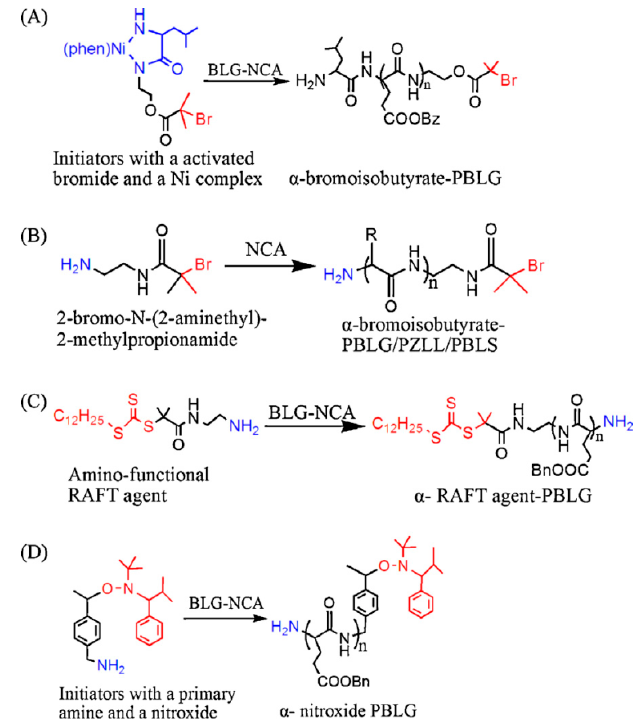
Figure 30. Dual initiators capable of promoting NCA polymerization and controlled radical polymerization. ( A , B ) Dual initiators for NCA polymerization and atom transfer radical polymerization (ATRP); ( C ) dual initiators for NCA polymerization and reversible addition-fragmentation chain-transfer (RAFT) polymerization; and ( D ) dual initiators for NCA polymerization and nitroxide-mediated radical polymerization (NMP). Reproduced with permission from reference [31].